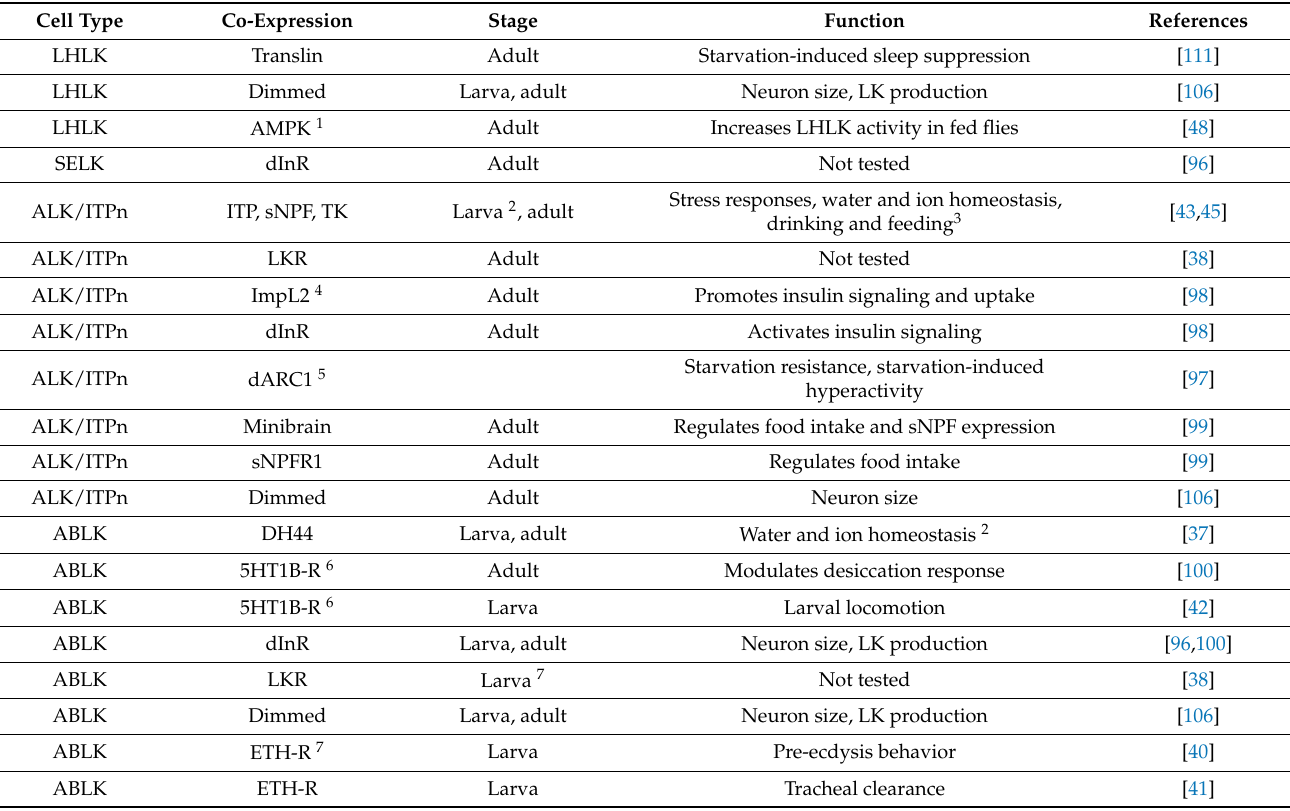
Table 1. Genes/proteins of interest that are expressed in LK neurons in Drosophila.